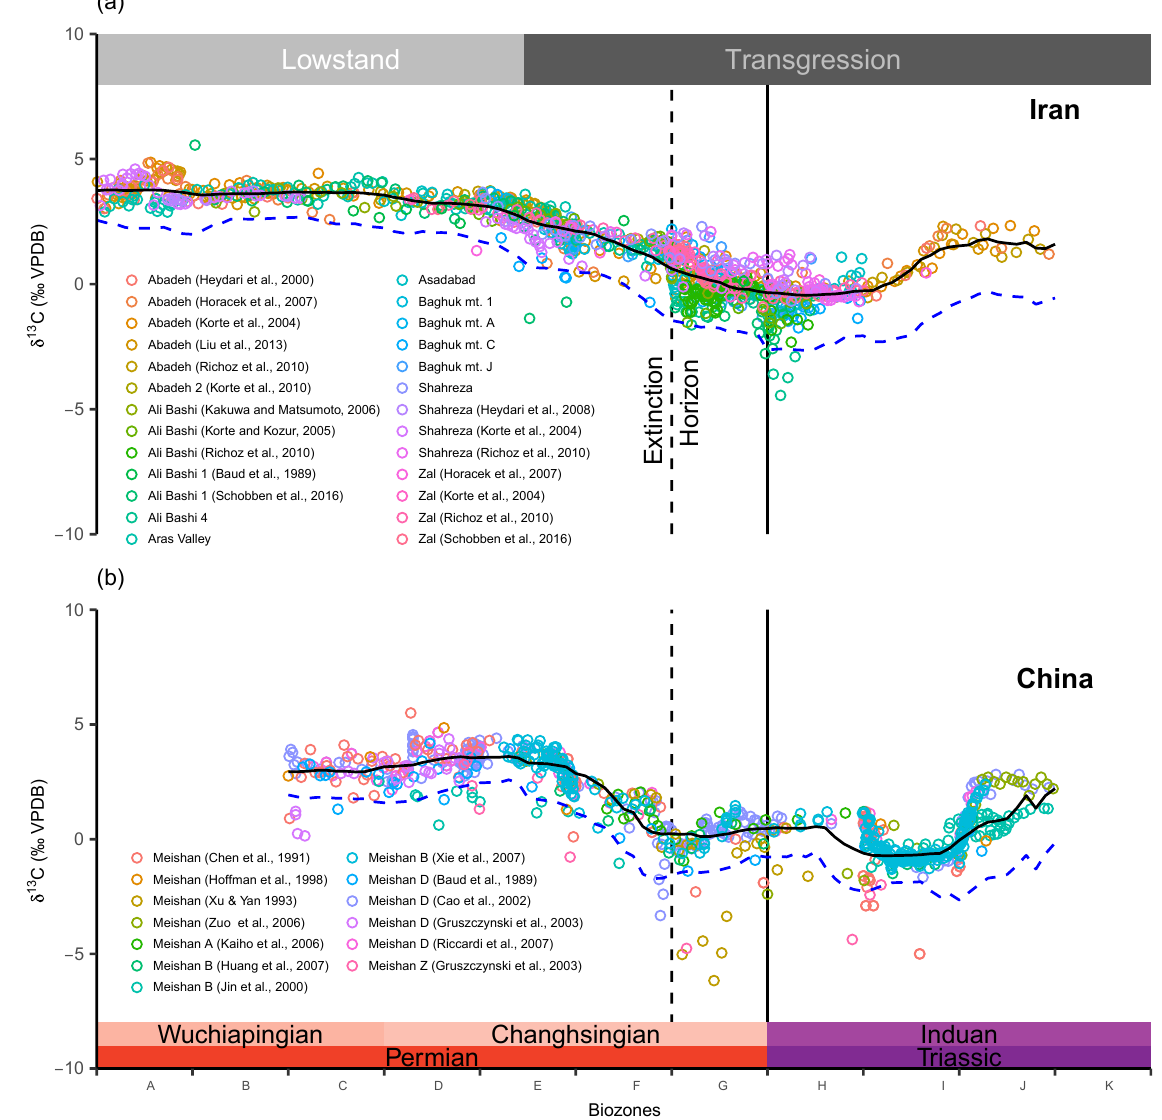
Figure 1. Compiled published and new data for multiple P–Tr rock sequences in Iran (a) and China (b) . The individual carbonate carbon isotope values are placed on a dimensionless timeline that marries both geographic areas in the most acceptable biochronological scheme (Table 1). The solid black line represents the subsampled median trend line. The dashed blue line depicts the seawater δ 13 C DIC curve as obtained from the time series simulation (Sect. 5). The stratigraphic placement of the sea level changes and the extinction horizon as well as the biostratigraphic framework can be found in the